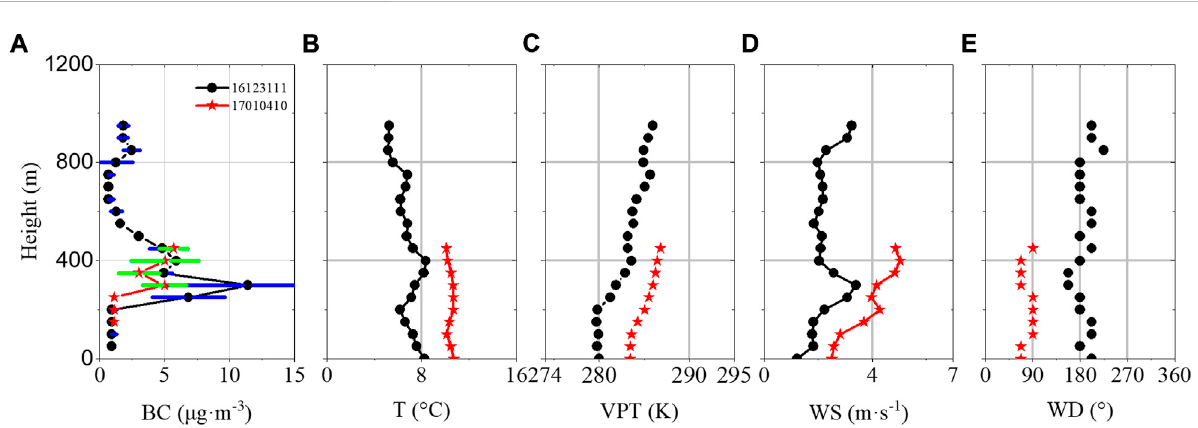
FIGURE 7 Thermally controlled transformation of stable to unstable boundary BC, T, VPT, WS and WD contours. The black line indicates the contours of eachelementat2016122311 andtheredlineindicatesthecontoursofeachelementat2017010410.GreenandbluelinesareBCerrorbars. (A)